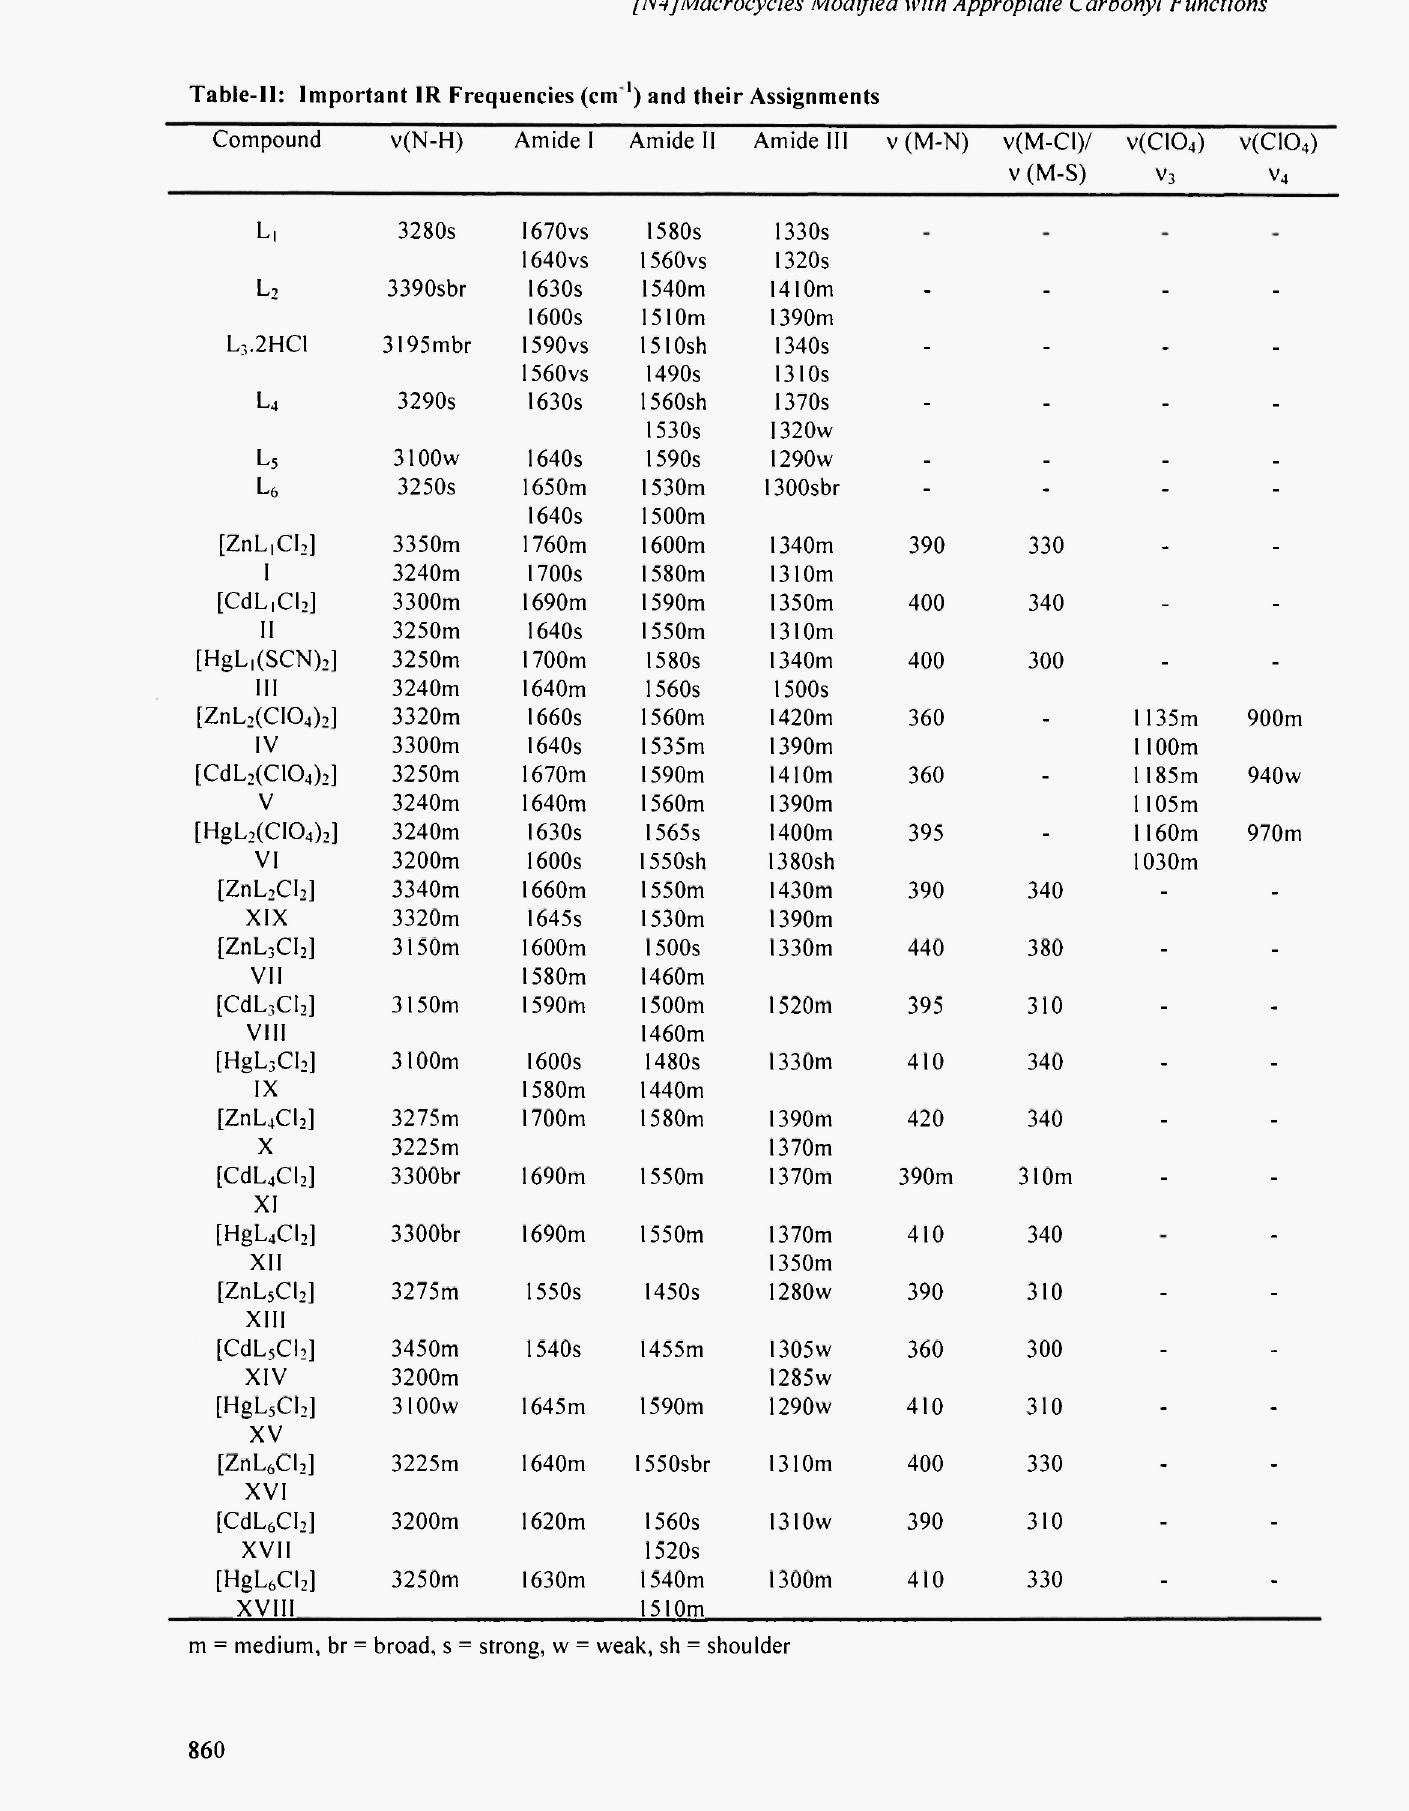
Table-II: Important IR Frequencies (cm 1 ) and their Assignments